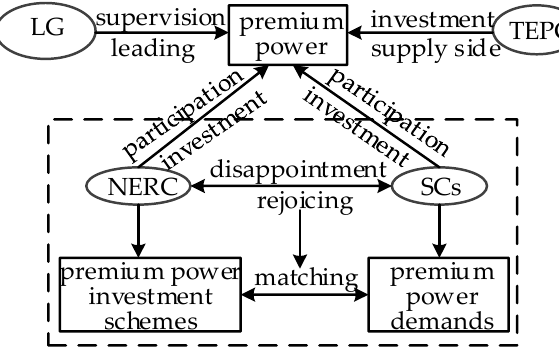
Figure 1. The multi-participant premium power investment strategy.